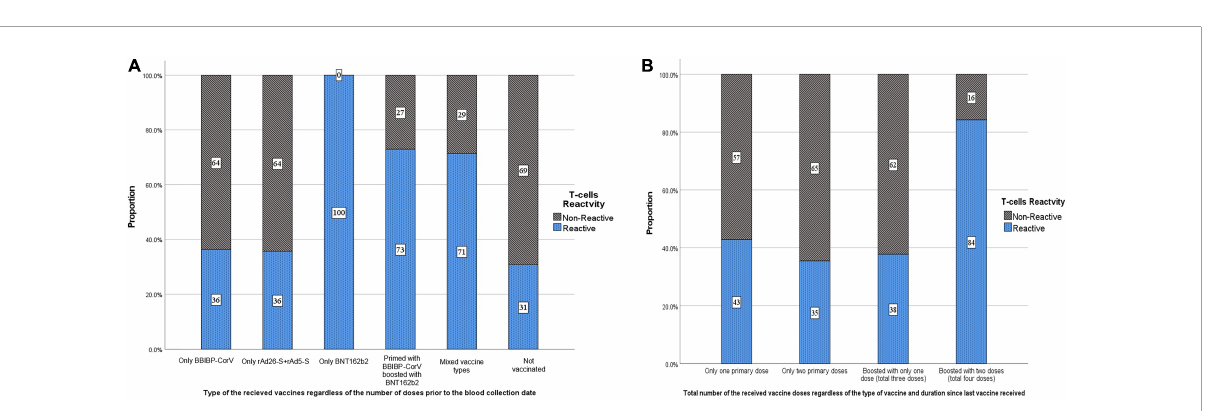
FIGURE2 Distribution of the study participants by T-cells reactivity (response) according to the (A) type and (B) total number of the received SARS-CoV-2 vaccine